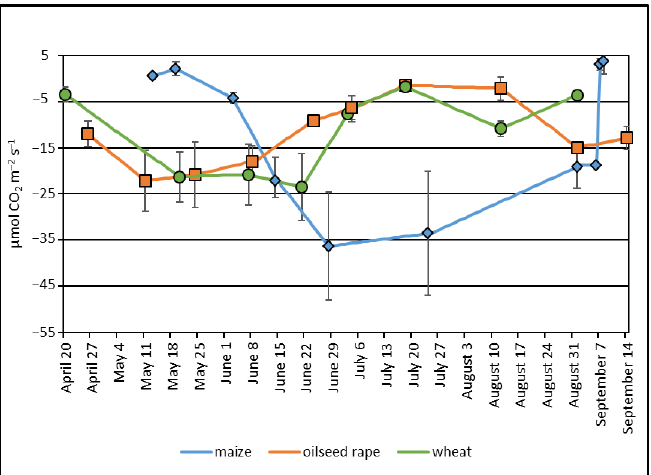
Figure 5. The CO 2 fluxes in wheat, oilseed rape and maize fields.